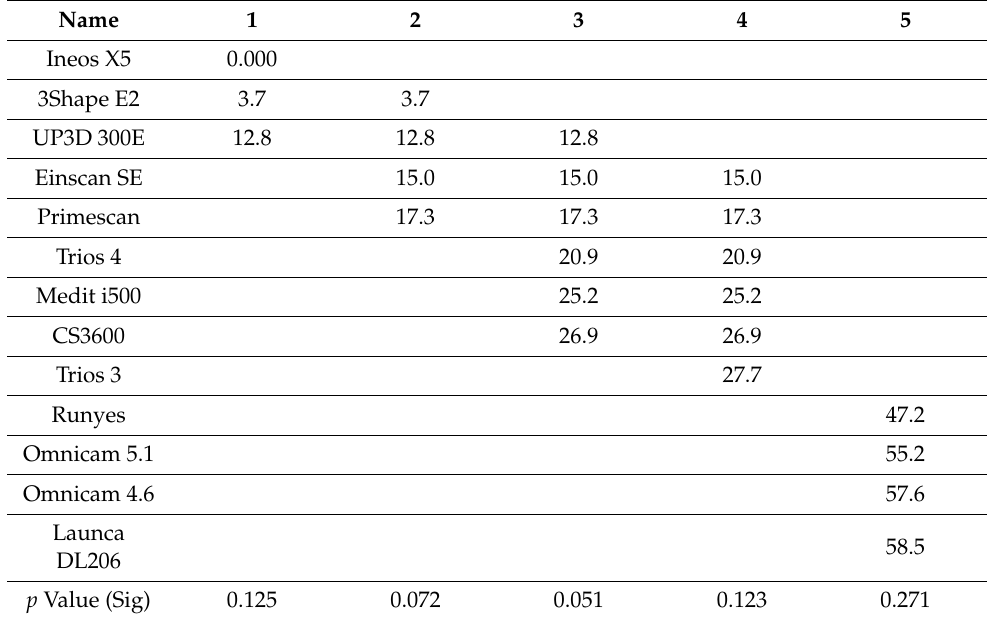
Table 3. Tukey homogenous subsets of compared means (subset for alpha =